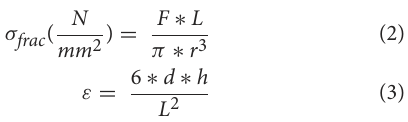
TABLE 3 Physical characterization of extruded pasta based on high protein quinoa. Extruded